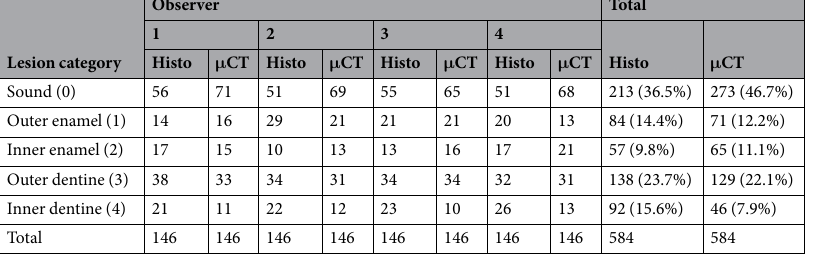
(Table 4). Applying the t-test for intra-examiner kappa ± SE), the difference between histology and micro-CT